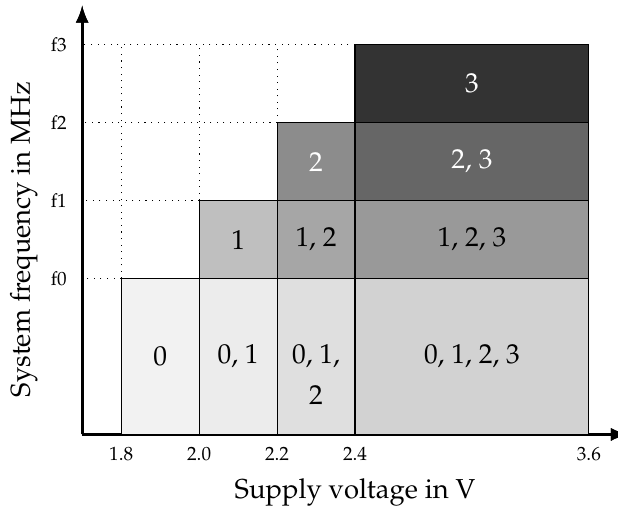
Figure 7. PMM core levels and related frequencies and threshold voltages.